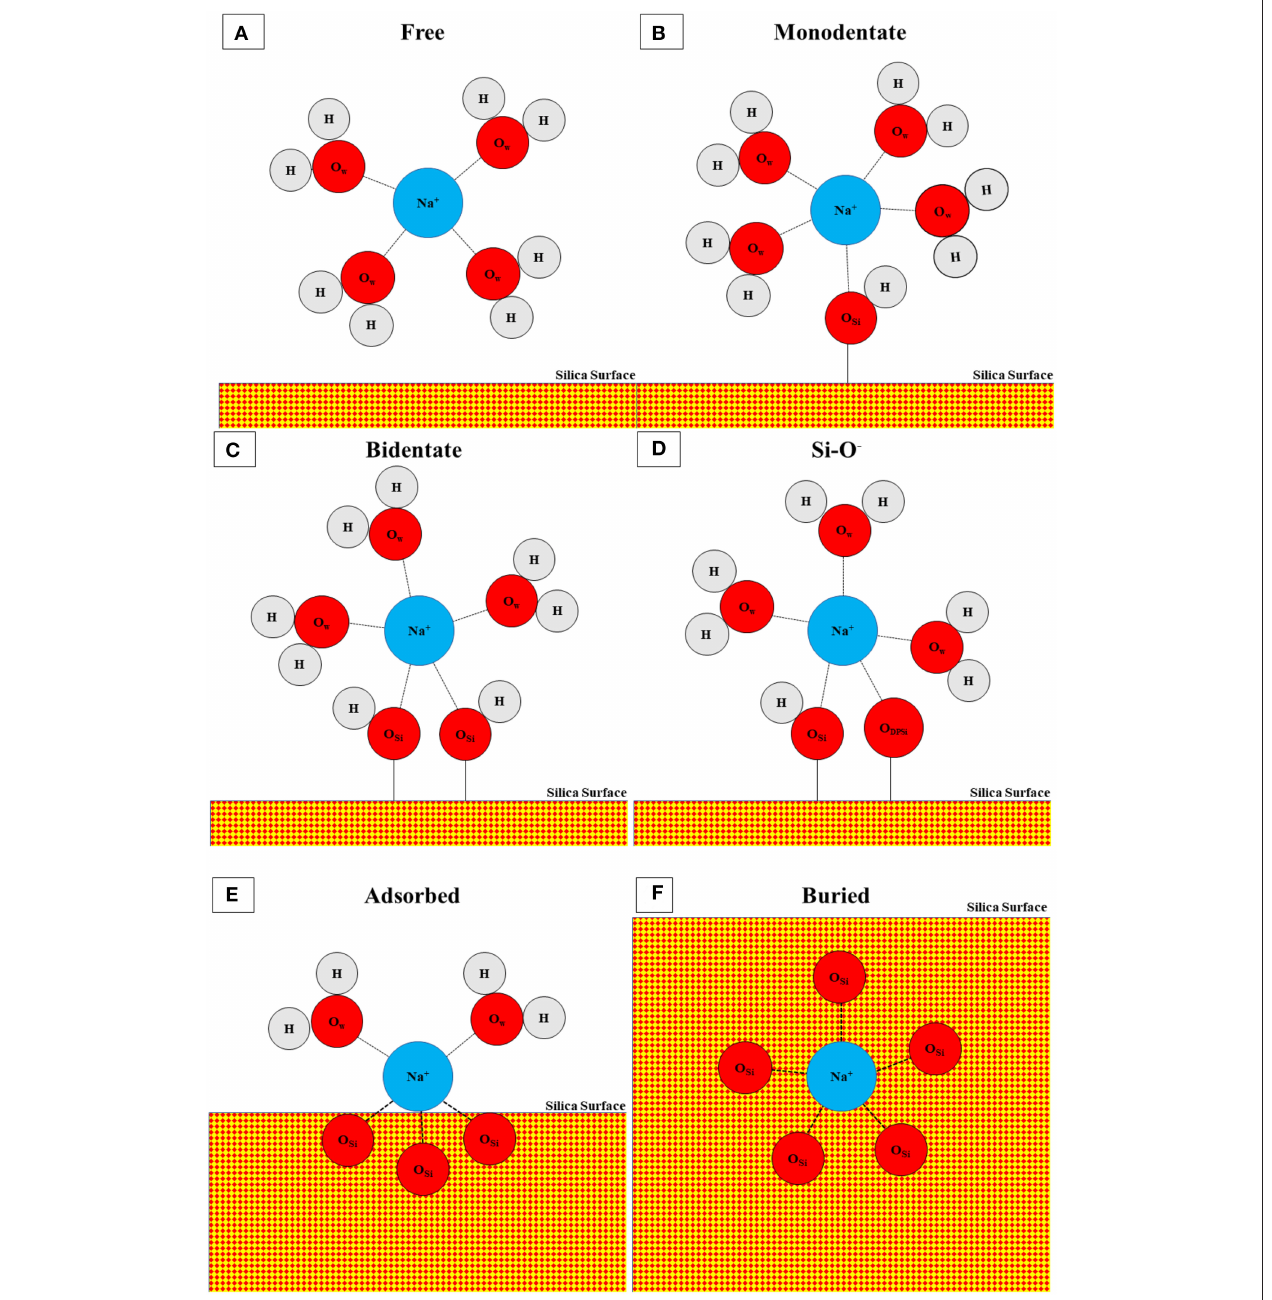
FIGURE 4 | Schematic of coordination structures for Na + including (A) free, (B) monodentate, (C) bidentate, (D) Si-O − , (E) adsorbed, and (F) buried. Tridentate and mixed configurations are not pictured. Atoms are represented with circles and bonds by connecting lines. Oxygen in water (O W ), oxygen in silicon (O Si ), and oxygen in deprotonated silanol (O DPSi ) are distinguished by subscript and silica is denoted with red-yellow checks. Not to scale.